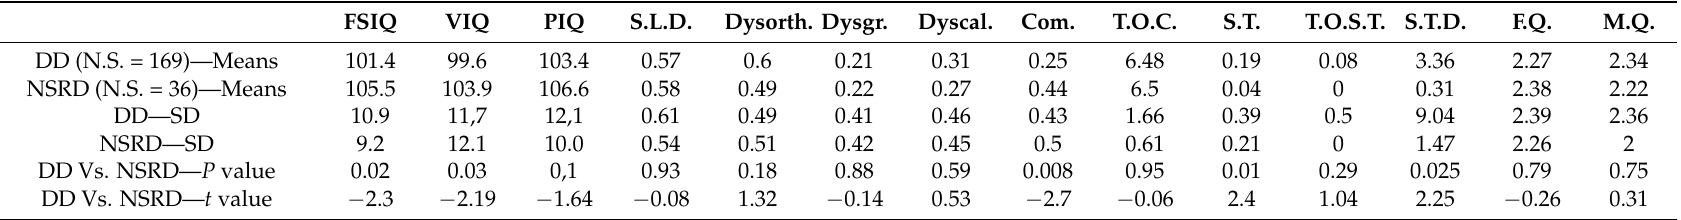
Table 1. t -test results of the anamnestic data of the two groups: mean, SD, t value and P value. DD. = Dysphonetic dyslexia, NSRD = Non-Specific Reading